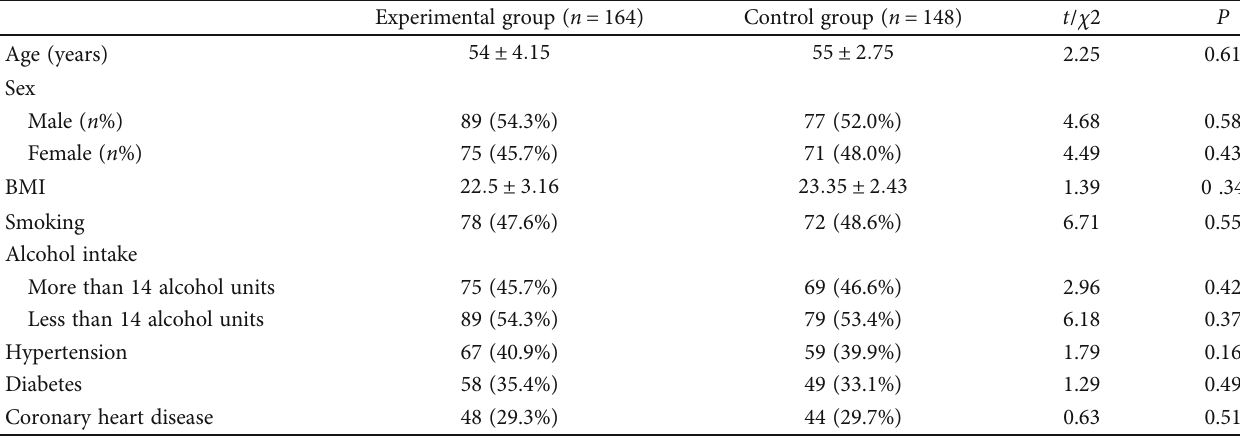
Table 1: Comparison of clinical characteristics of acute cerebral infarction complicated with microhemorrhage patients between two